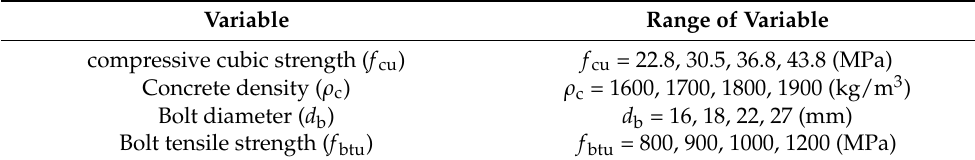
Table 2. Variables selected for parametric studies.